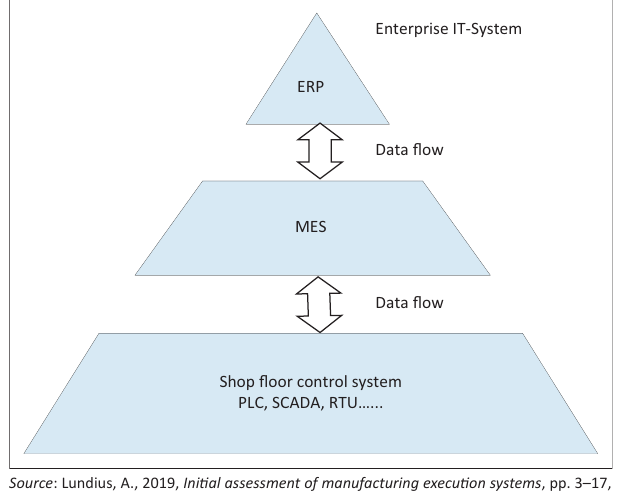
FIGURE 1: Traditional enterprise system